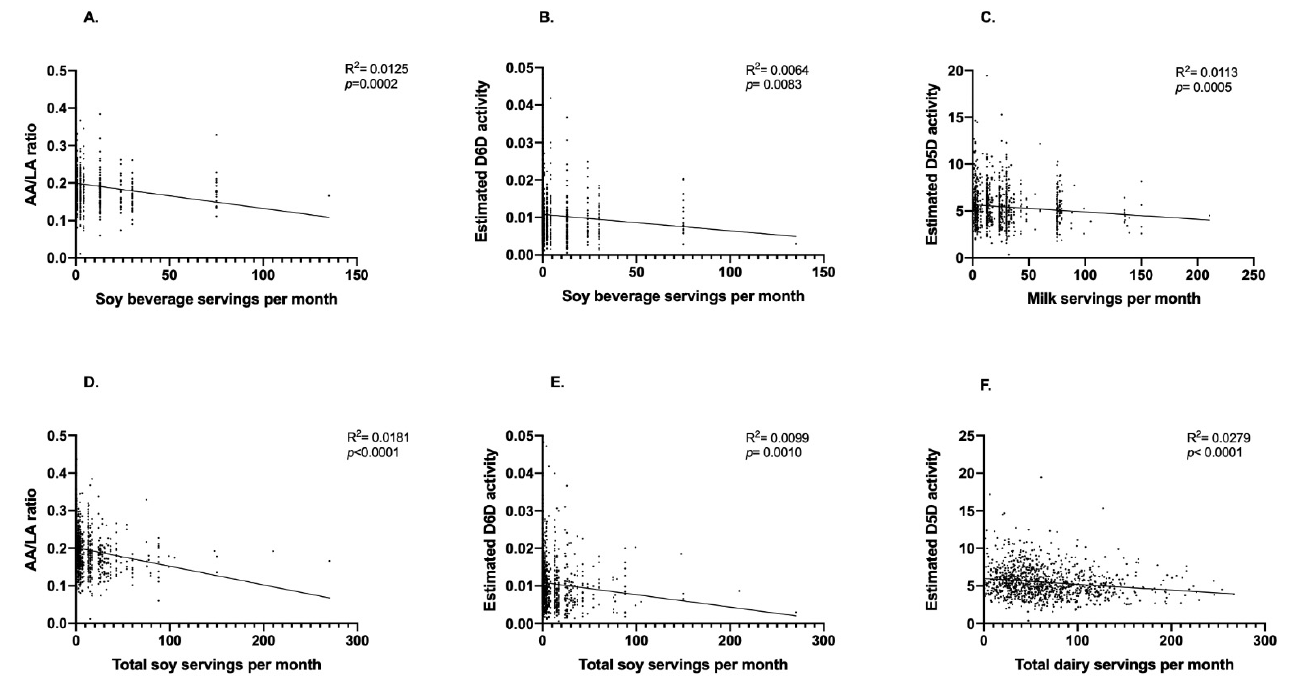
Figure 2. Relationships between soy beverage, fluid milk, total soy and total dairy intake with estimated desaturase activities. Pearson’s correlation was used to initially explore the relationships between soy beverage, fluid milk, total soy and total dairy intake with estimated desaturase activities. ( A ) Monthly servings of soy beverage and the AA/LA ratio, ( B ) monthly servings of soy beverage and estimated D6D activity, ( C ) monthly servings of fluid milk and estimated D5D activity, ( D ) monthly servings of total soy and the AA/LA ratio, ( E ) monthly servings total soy and estimated D6D activity, and ( F ) monthly servings of total dairy and estimated D5D activity; n = 1083 participants.